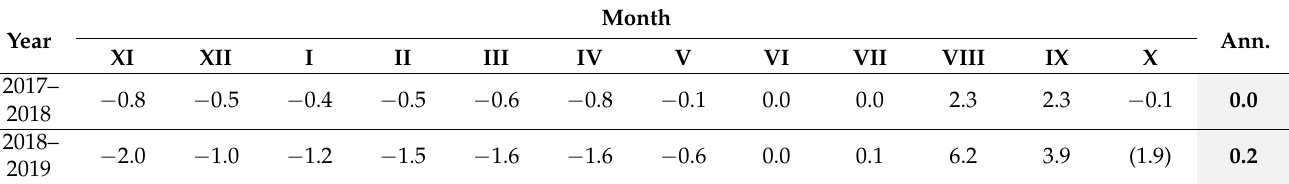
Table 8. Mean monthly temperatures at Banski suhodol